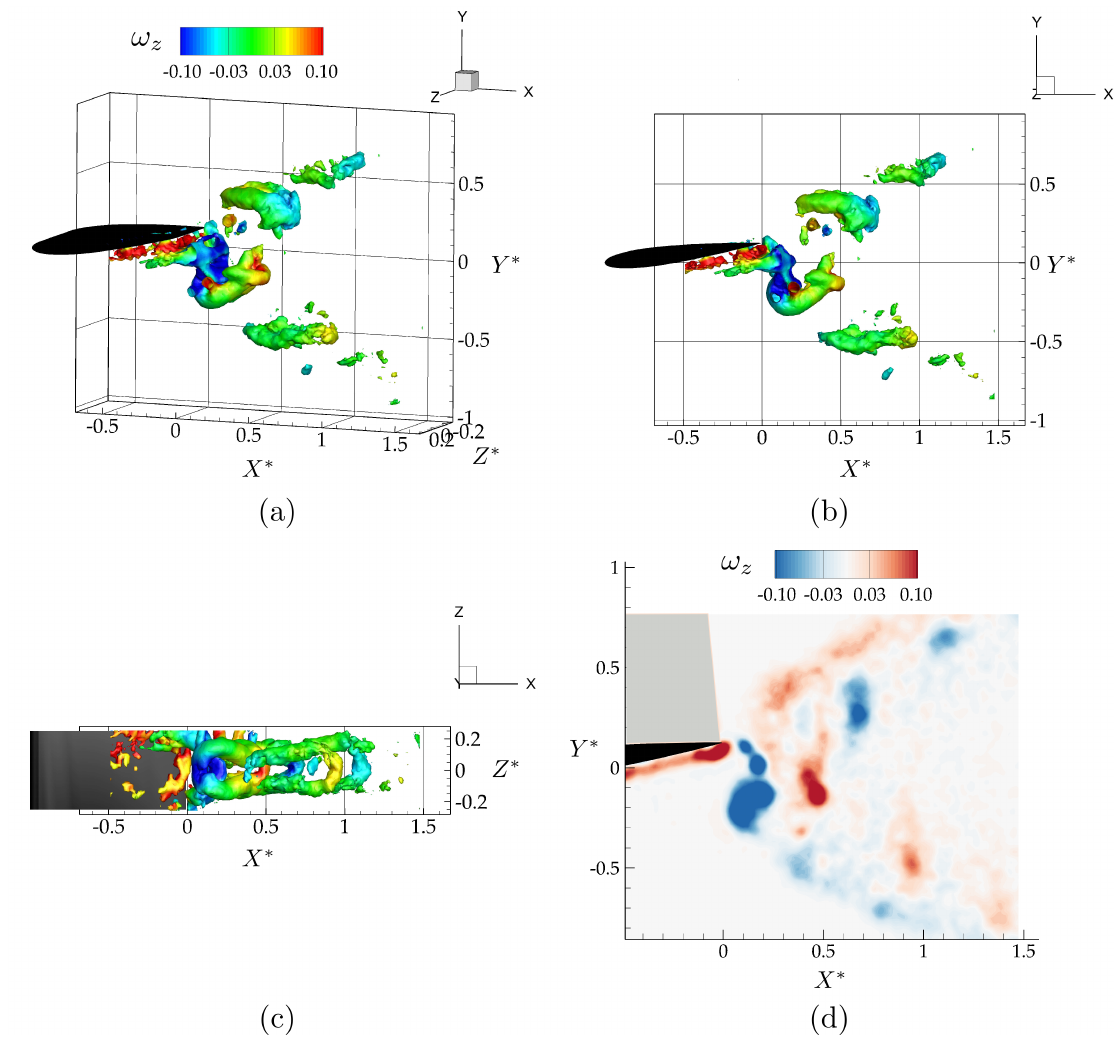
Figure 4. Wake structures shedding from the trailing edge of an isolated wing shown with λ 2 = − 0.07 isocontours at the dimensionless time of t ∗ = 0.25, as an isometric ( a ), side ( b ), and top ( c ) view of the flowfield, and vorticity contours ( ω z ) in the mid-span plane ( d